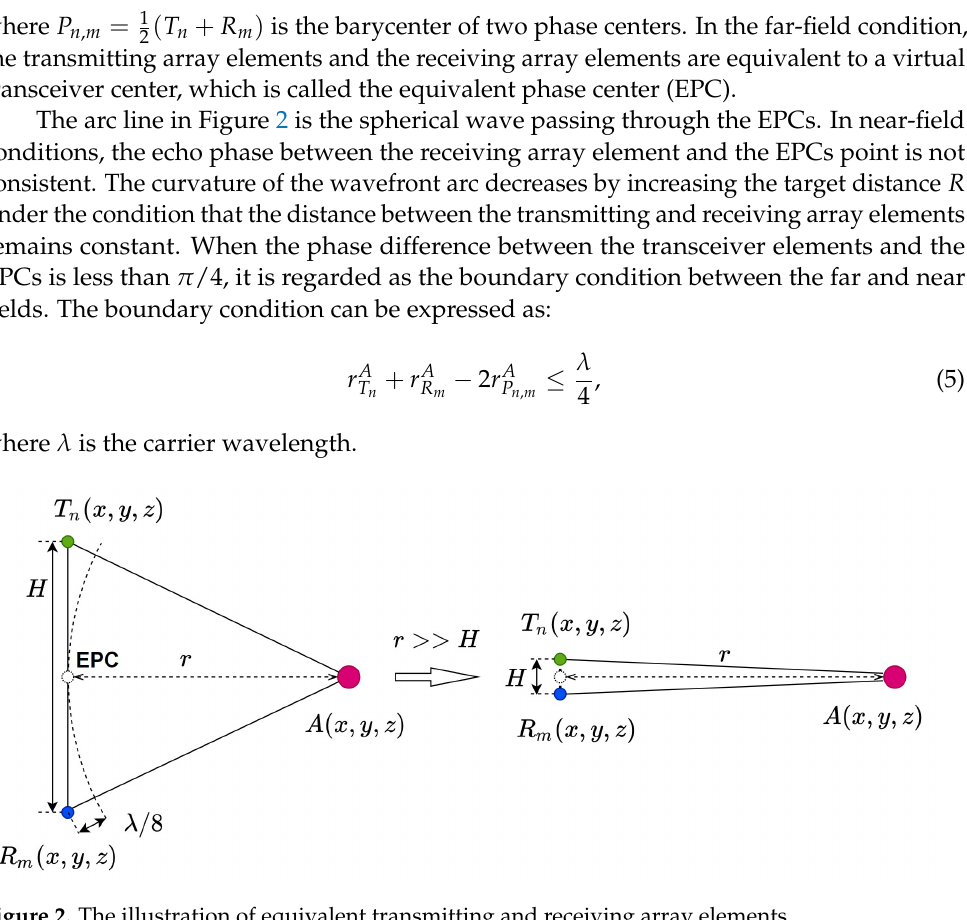
Figure 2. The illustration of equivalent transmitting and receiving array